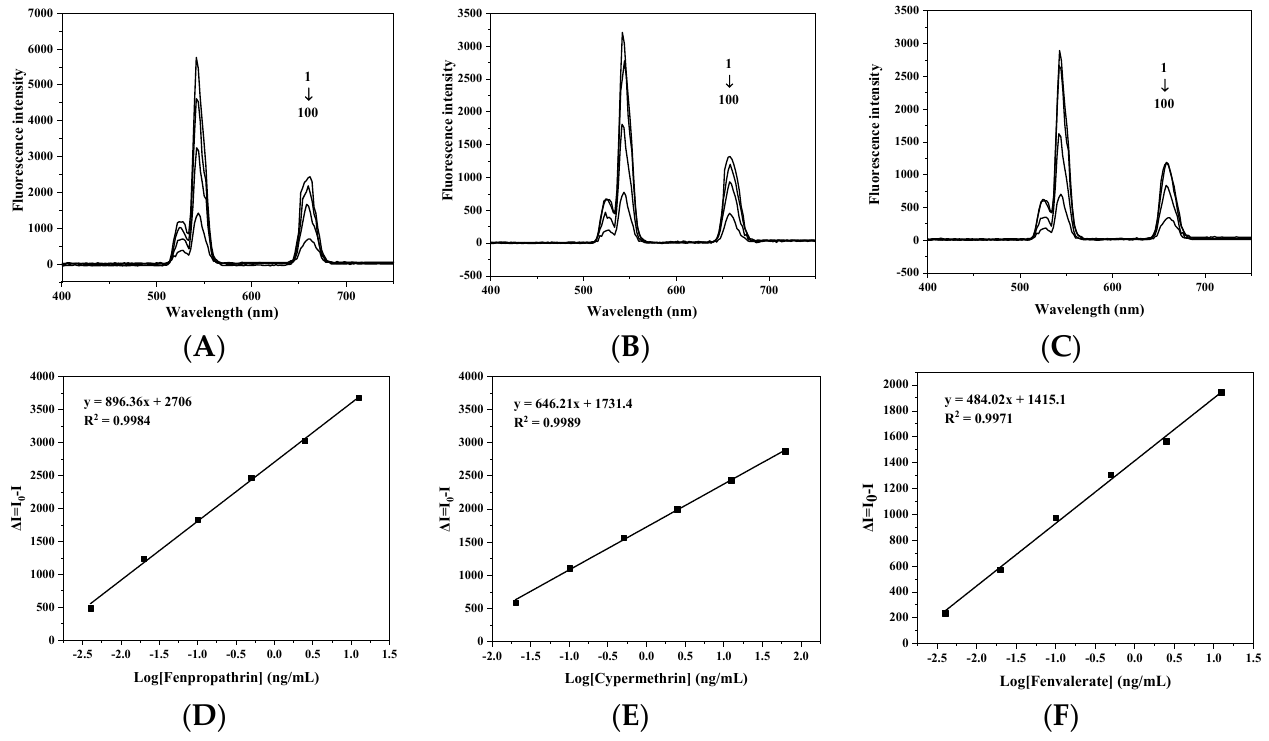
Figure 4. ( A ) Upconversion fluorescence spectrum of fenpropathrin at different concentrations; ( B ) Upconversion fluorescence spectrum of cypermethrin at different concentrations; ( C ) Upconversion fluorescence spectrum of fenvalerate at different concentrations; ( D ) Standard curve of fenpropathrin; ( E ) Standard curve of cypermethrin; and ( F ) Standard curve of fenvalerate. Proteins, sugars and pigments in the sample will interfere with the test results. The influence of the matrix could be reduced by sample dilution. Apple, pear, cabbage and cu- cumber samples were extracted with acetonitrile and diluted with PBS 5, 10 and 20 times re- spectively. The standard inhibition curve was drawn with the concentration of pyrethroids as the abscissa and the fluorescence intensity as the ordinate. The results are shown in Figure 5. When cucumber and cabbage samples were diluted 10 times and apple and pear were diluted 20 times, the standard inhibition curve was similar to the standard curve of the established method. It showed that the matrix effect could be eliminated when the cabbage and cucumber were diluted 10 times, and apple and pear were diluted 20